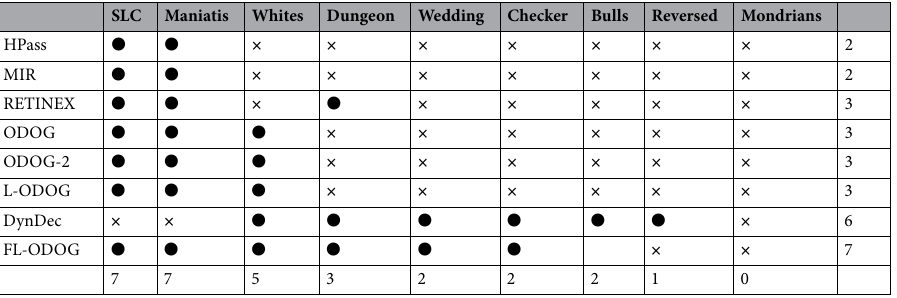
Table 2. Summary of findings. Circle indicates that the model matched the direction of